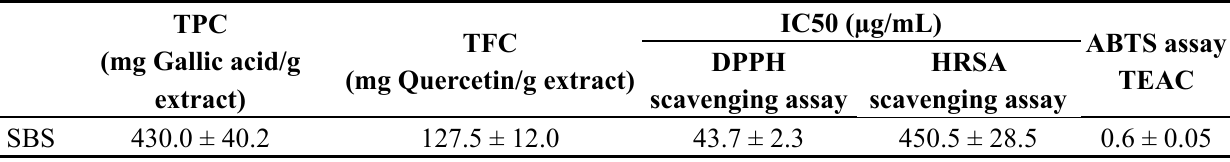
Table 2. Antioxidant capacities, total phenolic and flavonoids content of Sasa borealis stem (SBS)